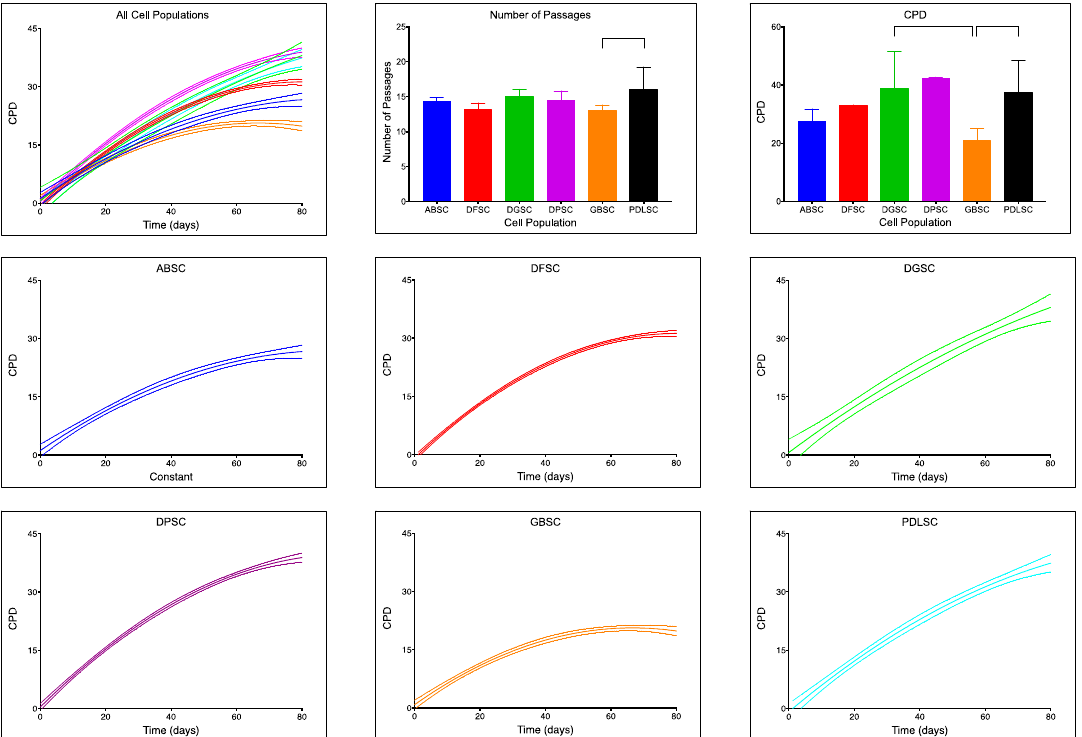
Figure 1. Proliferative curves (dashed lines represent 95% CI), number of passages (mean(SD)) and total accumulated population duplications (CPDs) (mean(SD)) for each cell population. Note the different slopes of each curve and different maximum CPD after 80 days in culture. Only the comparisons between total number of passages for grafted bone (GBSC) and periodontal ligament (PDLSC) ( p = 0.027; Dunn’s multiple comparison test) and total CPD between GBSC and dental germ (DGSC) ( p = 0.005; Dunn’s multiple comparison test) and between GBSC and PDLSC ( p = 0.001; Dunn’s multiple comparison test) were statistically significant. Table 1. Best-fit values of accumulated population duplications (CPD) curves for each cell population.